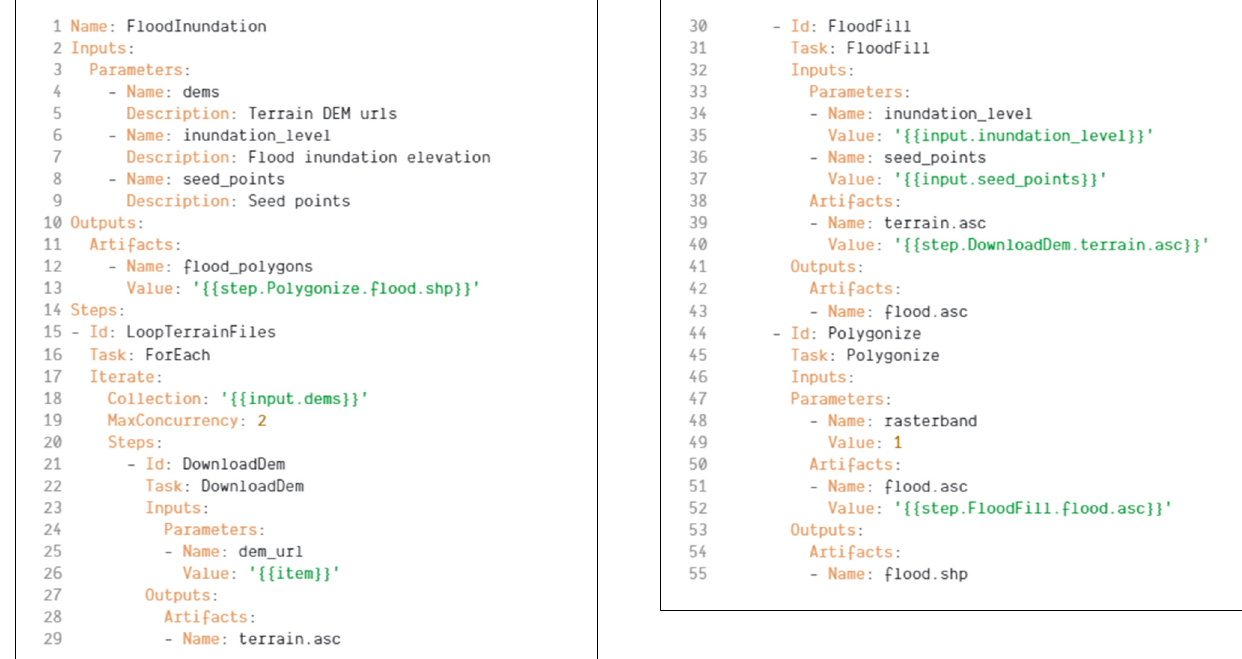
Figure 16. A real-world example, workflow definition of flood inundation prediction in the proposed workflow definition model.